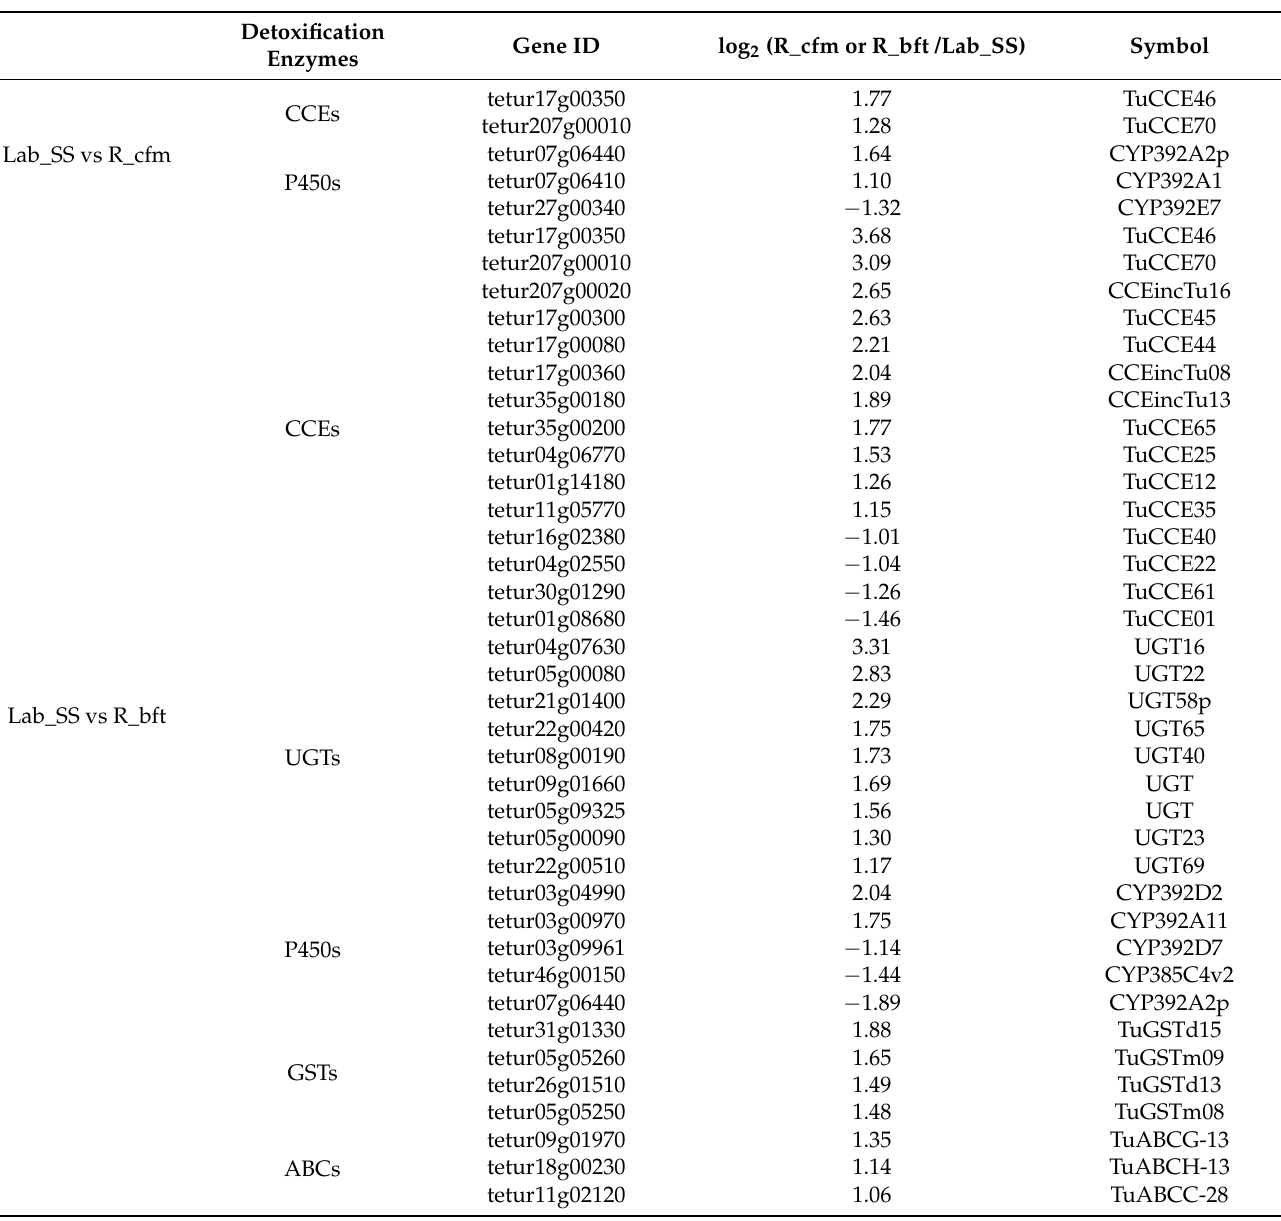
Table 3. The DEGs of detoxification enzymes in the cyflumetofen-resistant strain and the bifenthrin- resistant strain of T.